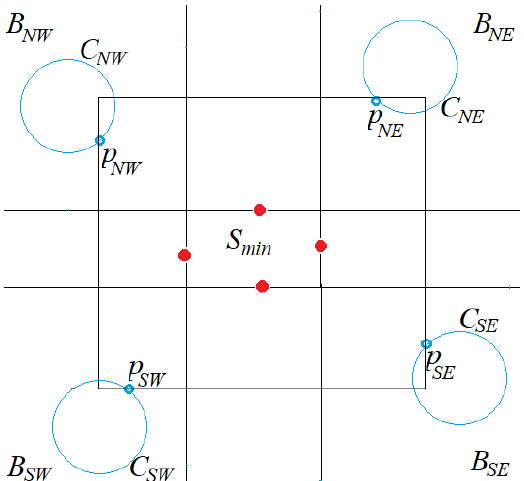
Figure 10. If the MBSR among R and B (cid:48) were bounded by a point p ∈ C , it would intersect C